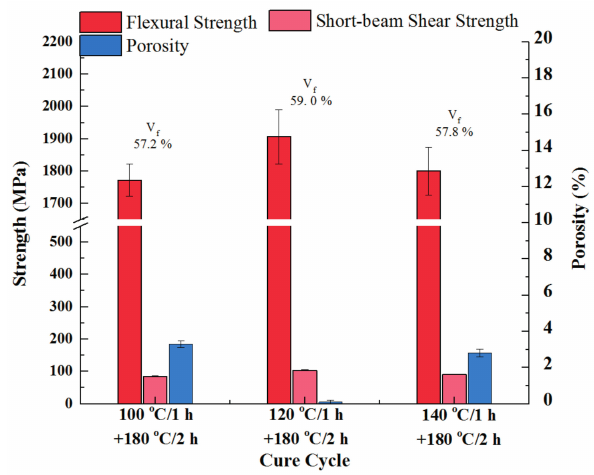
Figure 7. Effect of initial cure temperature on mechanical properties and void content of